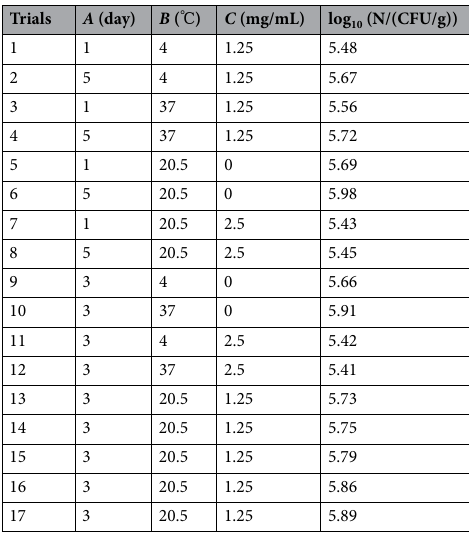
Table 1. Box–Behnken experimental design and